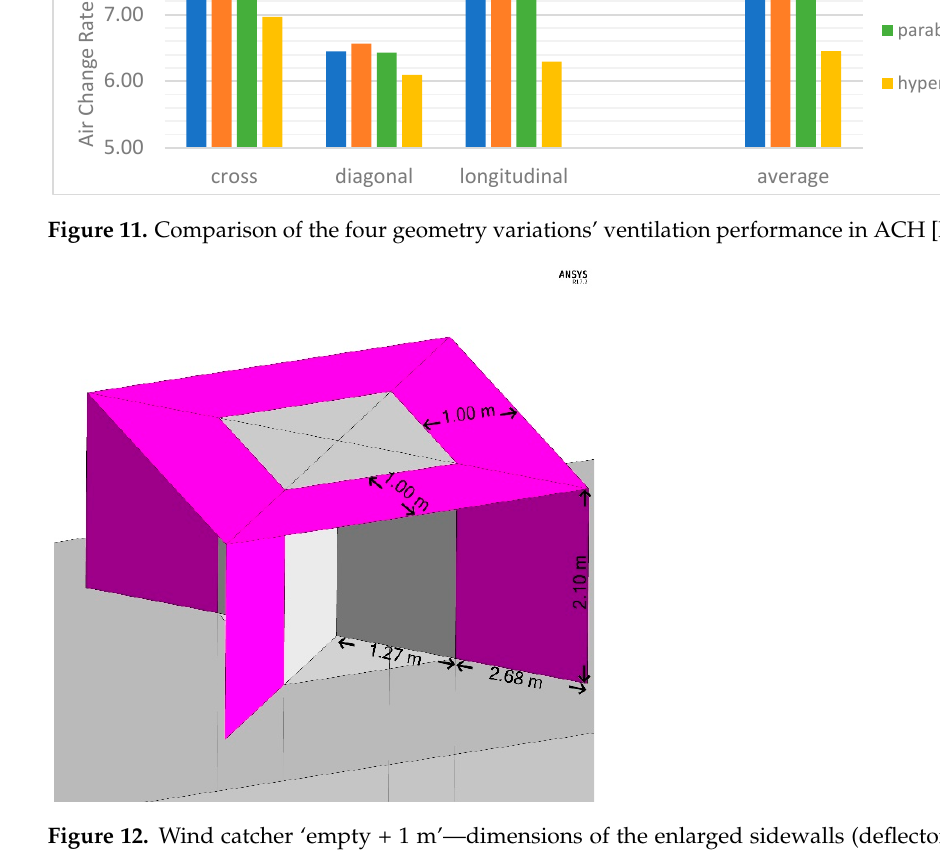
Figure 11. Comparison of the four geometry variations’ ventilation performance in ACH [h − 1 ].